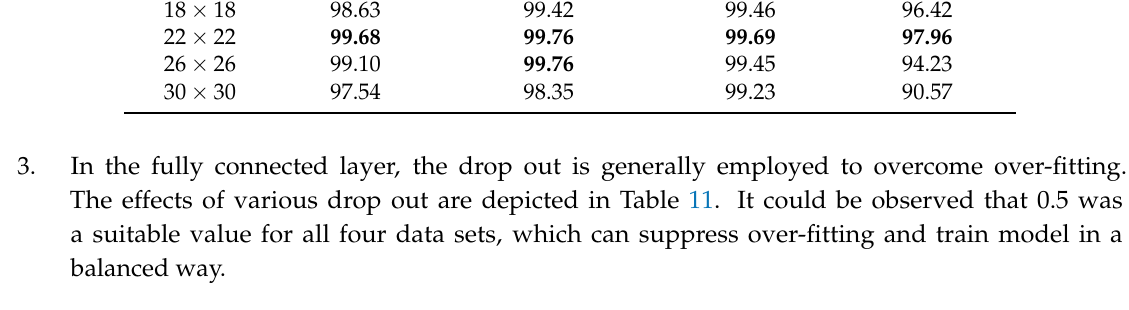
Table 11. OA of the proposed method with different drop